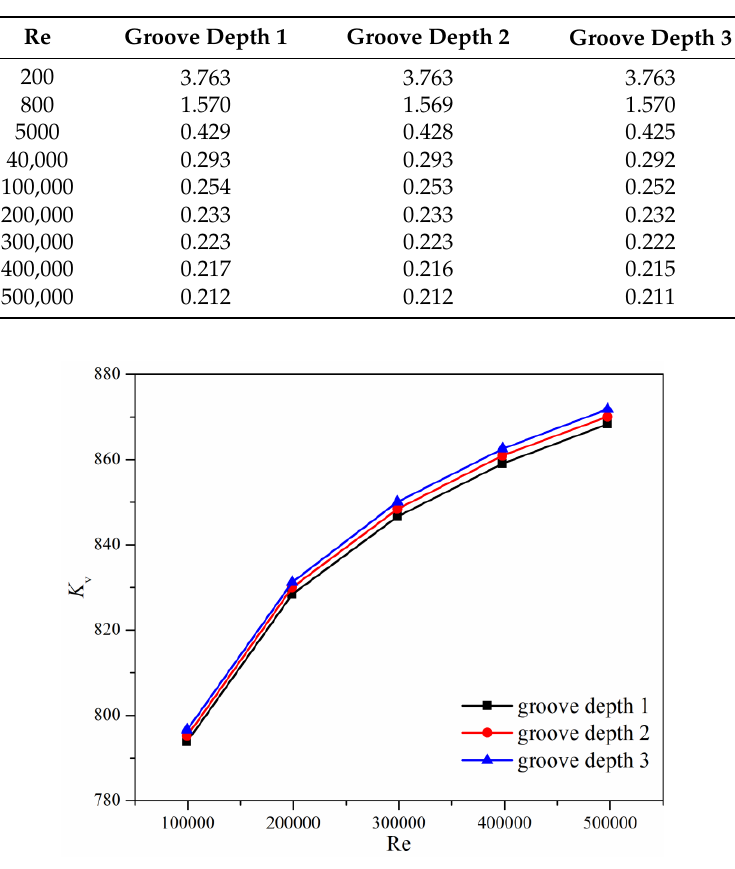
( b ) Figure 14. The path of the stress linearization analysis and the stress distribution along the path: ( a ) The path of the stress linearization analysis; and, ( b ) The stress distribution along the path. It can be found in Figure 14 that the maximum of the stress is 152.1 MPa, and the location where there is the maximum stress is 32.5 mm away from the end face of the bolt, where the contact position of the bolt and the limit stop is.